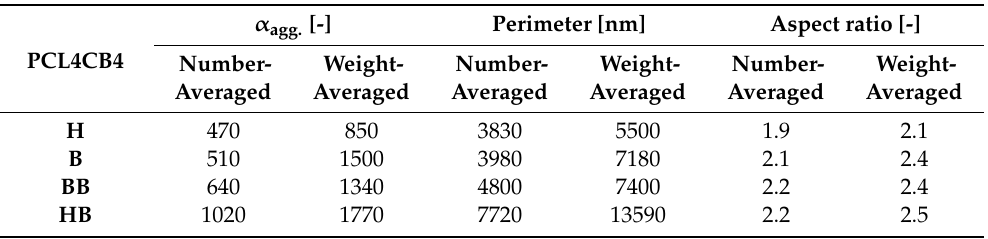
Figure 5. Aspect ratio (AR) vs. perimeter (P) of the PCL4CB4 ternary composites: ( a ) H_PCL4CB4, ( b ) B_PCL4CB4, ( c ) BB_PCL4CB4, and ( d ) HB_PCL4CB4 (the box with dotted line represents the distribution of AR, perimeter of aggregates in B_CB4). Table 4. Number-averaged and weight-averaged aggregate size ( α agg. ), perimeter, and aspect ratio of CB aggregates in ternary composites depending on the mixing method.